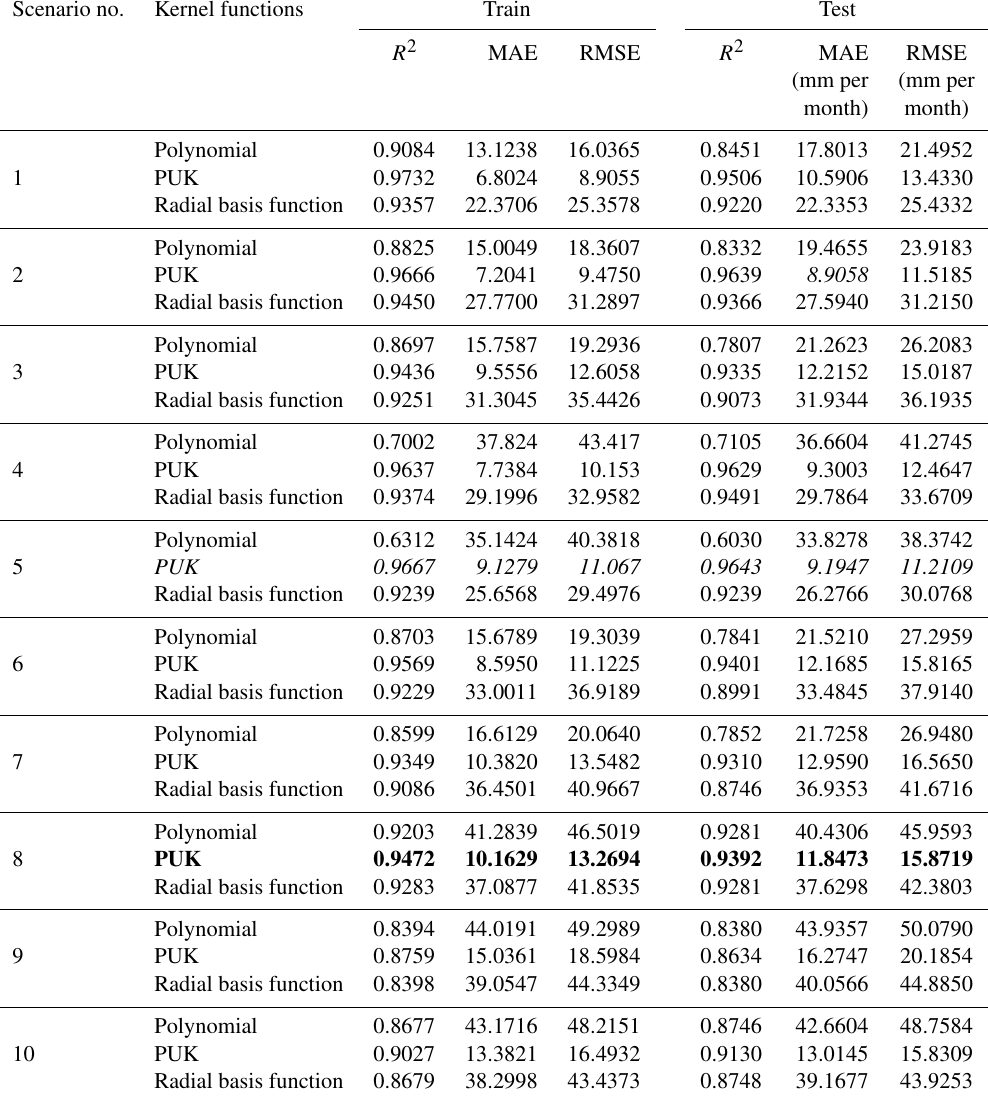
Table 4. Outcomes of the GPR modelling approach from different kernel functions based on R 2 , MAE, and RMSE (italic font represents the best results; bold represents the optimally selected